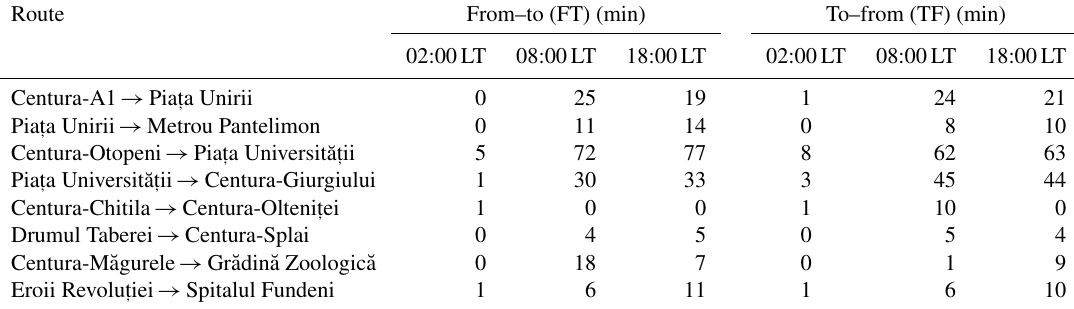
Table 5. Time differences (expressed in minutes) between various OD pairs shown in Fig. 10 and for pre- and post-earthquake conditions.